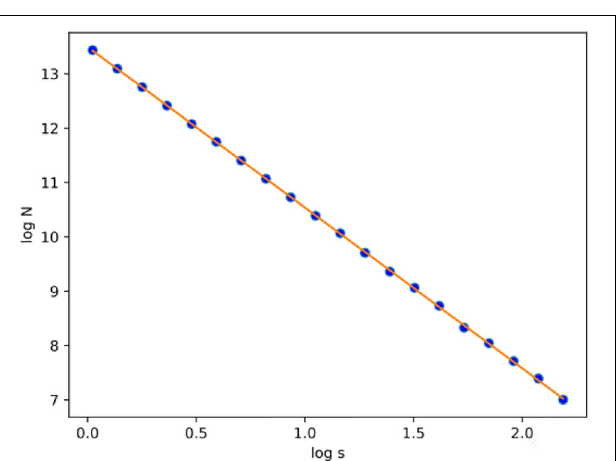
FIGURE 8 | After calculating the logN/logs plot spots using the least square error, the fitted line is estimated for subject OAS30001_MR_d0129. Experiments have shown that at least 20 iterations were enough to estimate FD. Also, the linear relation of logN and logs suggests that FD efficiently describes the complexity of the structure; therefore, the multifractal analysis is not required. Root-mean-square error (RMSE) can describe how well a linear regression model describes the data. For data points close to the output line of the regression model, RMSE is expected to be low; therefore, the estimated FD is close to the theoretical solution. The two variables used in the linear regression model are the number of boxes ( N ) and the current scale (s). If a linear relationship describes the two variables, then the structure can be described by FD. If not, the structure is considered to have multifractal